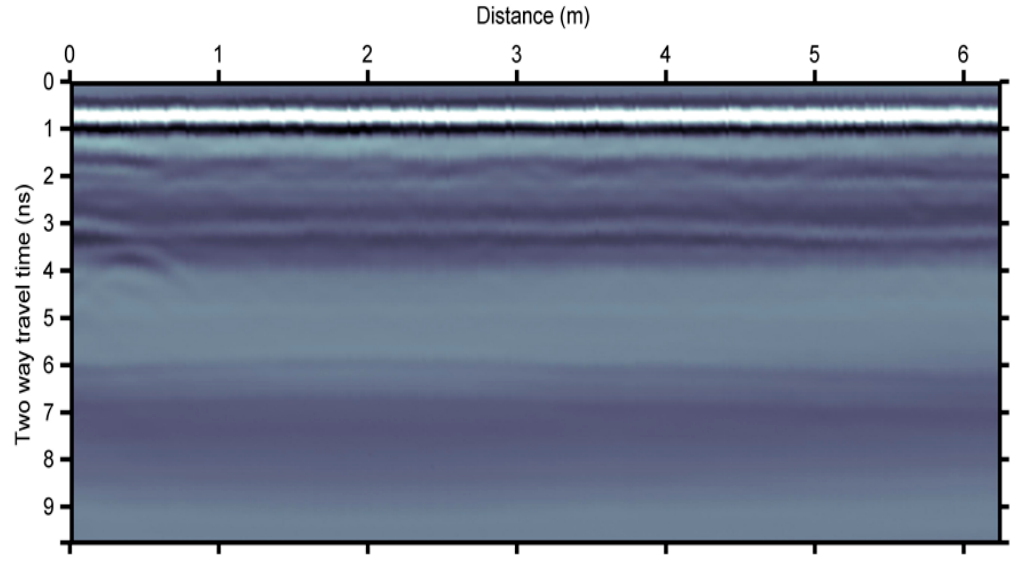
Figure 5. The GPR section after time-zero corrections.